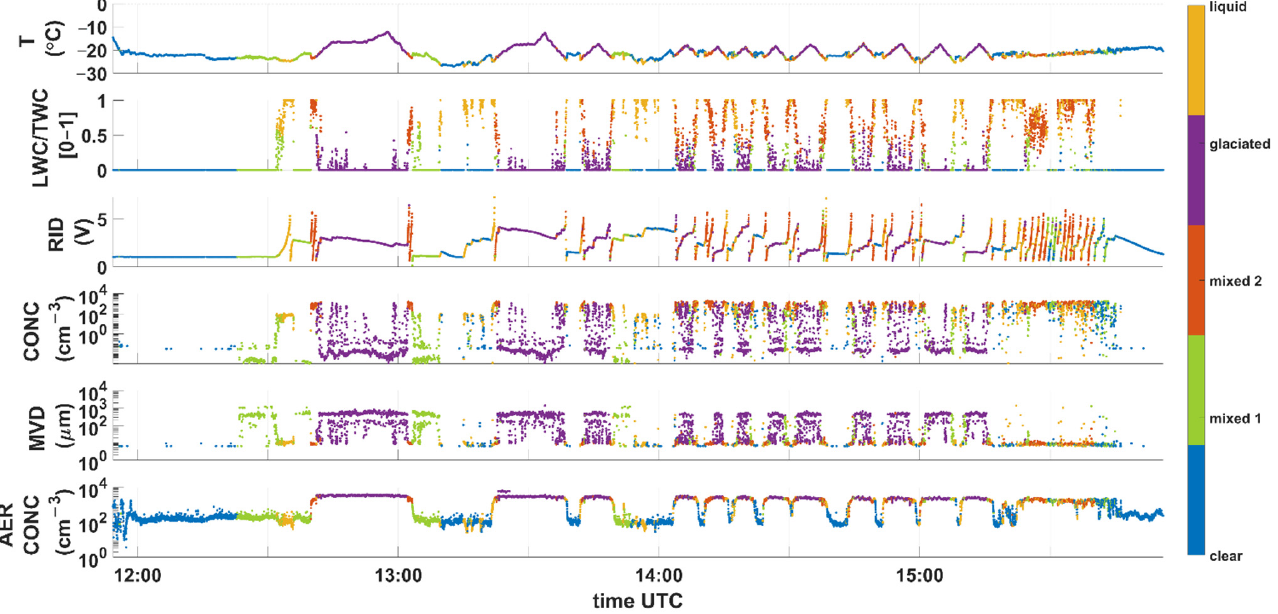
Figure 11. Time series of in situ measurements collected in flight F28 on 5 March 2019. Color coding denotes different clusters assigned by the k-means algorithm. From Top to Bottom, the panels illustrate probe measurement from the temperature sensor, LWC/TWC ratio, RID, combined FSSP and OAP concentration and MVD, and aerosol number concentration.